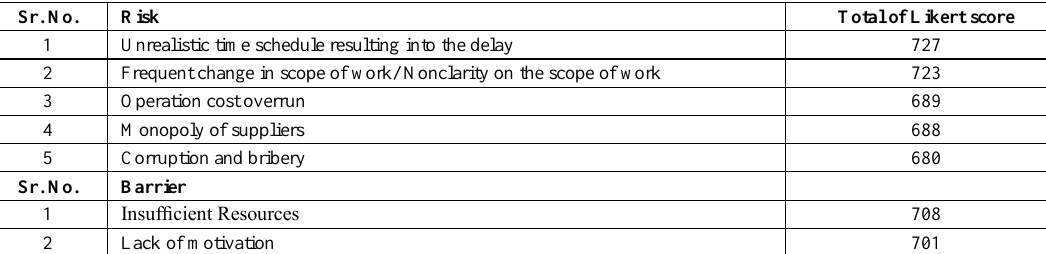
Table 3. Identified risk and barriers